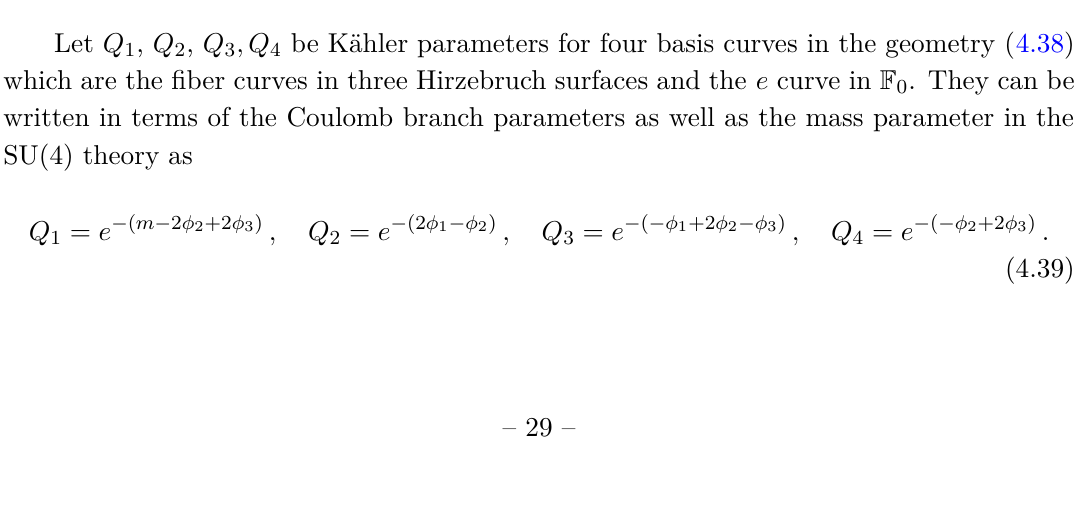
Q Q d Q 1 / 3 i 2 3 i